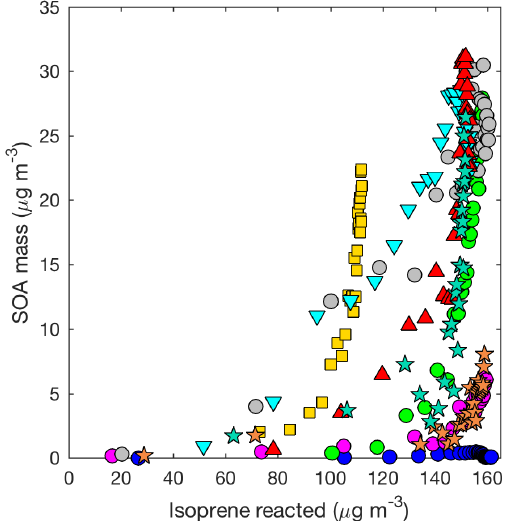
Figure 4. SOA mass yield (20min averages) as measured by the DMA assuming a density of 1.4gcm − 3 for all LV pathway experiments: seed surface area (SA) – D1 (SA = 0µm 2 cm − 3 ; blue dot), D2 (SA = 1170µm 2 cm − 3 ; ma- genta dot), D3 (SA = 3420µm 2 cm − 3 ; green dot), and D4 (SA = 5770µm 2 cm − 3 ; gray dot); temperature – D5 (13 ◦ C; in- verted cyan triangle) and D6 (32 ◦ C; red triangle); isoprene loading – D7 (initial isoprene 110µgm − 3 ; yellow square); and new cham- ber with less wall charging – D10 (SA = 1580µm 2 cm − 3 , orange star) and D11 (SA = 4770µm 2 cm − 3 ; teal star).